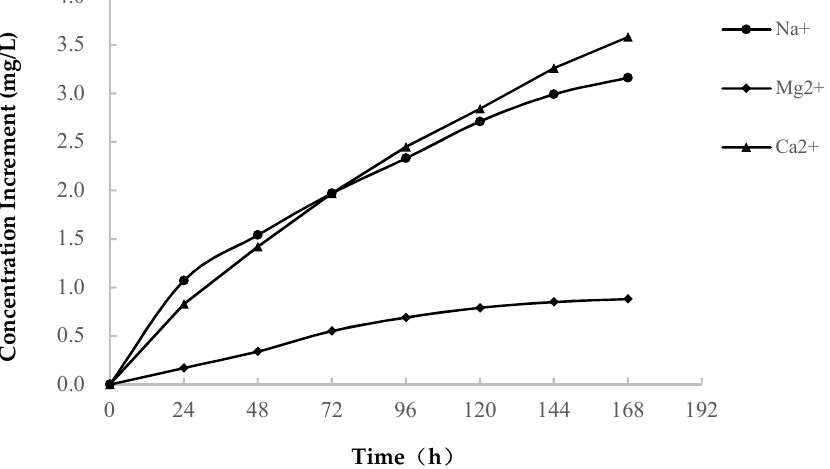
Figure 5. The change curve of the ion concentration in each 0.1 mol/L solution.